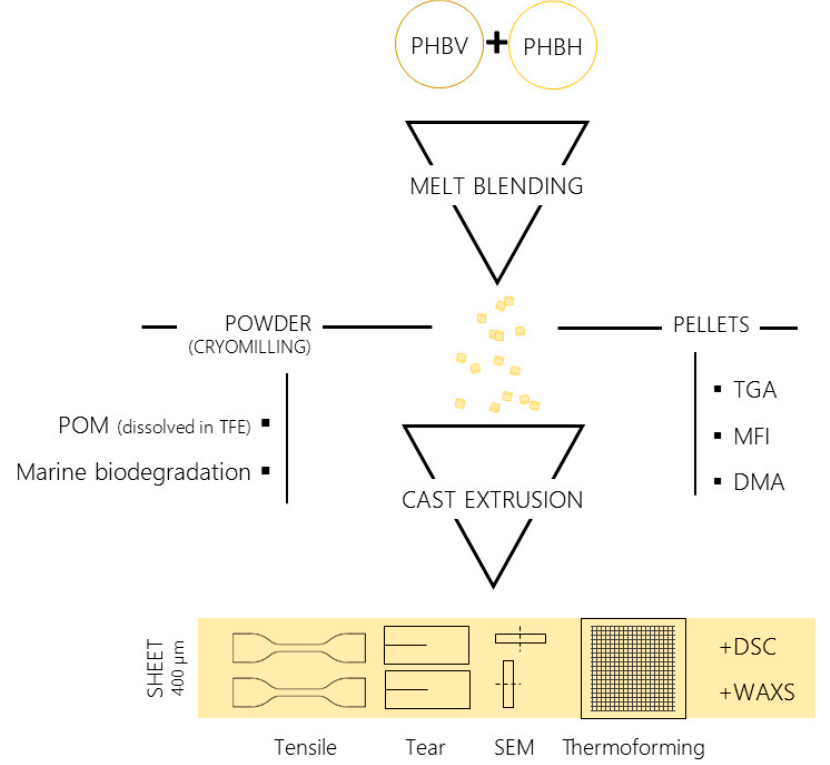
Figure 1. Scheme of sample preparation and characterization carried out. For subsequent cast extrusion, all of the PHA pellets were dried at 60 ◦ C for at least 4 h in a dehumidifier (Piovan DPA 10). Each sample was cast extruded into a 400 µ m sheet using a single-screw extruder Rheomix 3000P ThermoHaake